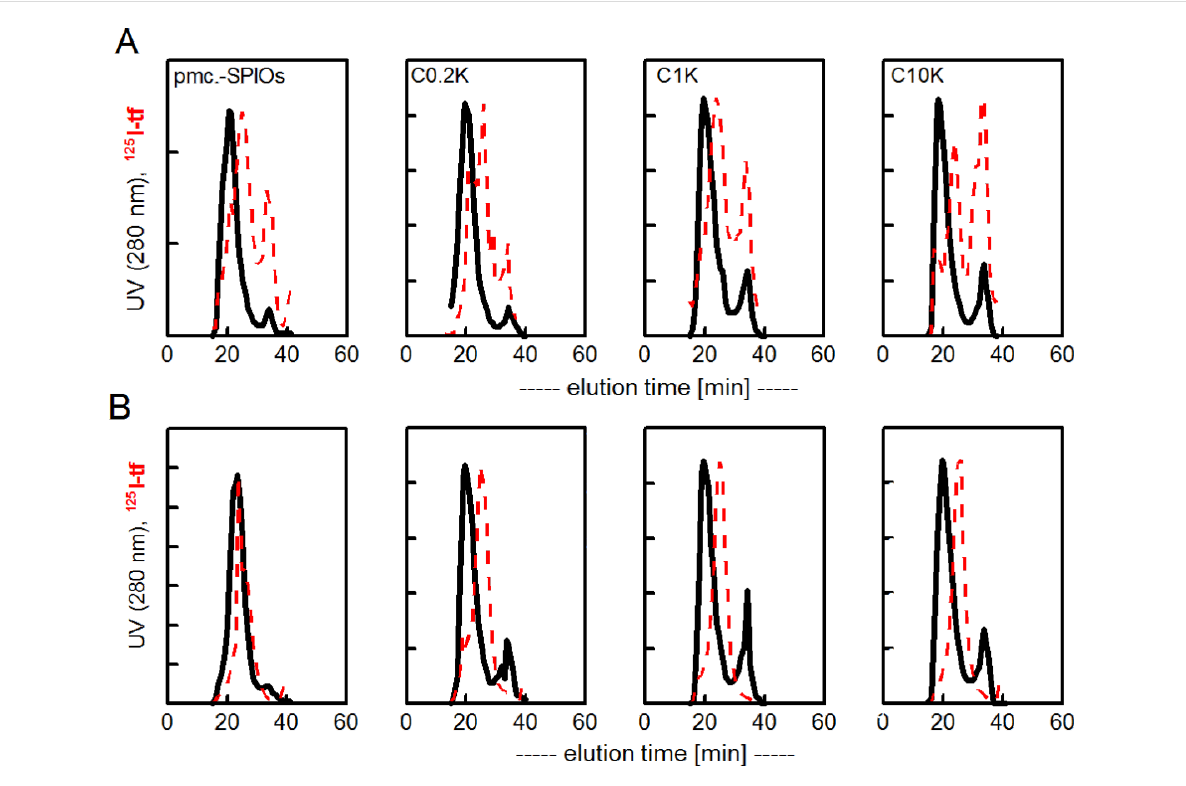
Figure 2: Stability of a preformed 125 I-transferrin corona after exchange with excess of albumin. A, 125 I-transferrin was first adsorbed to different PEGylated SPIOs. After removal of free unbound protein by filtration, a 3 fold excess of bovine albumin was added. FPLC analysis followed a 2